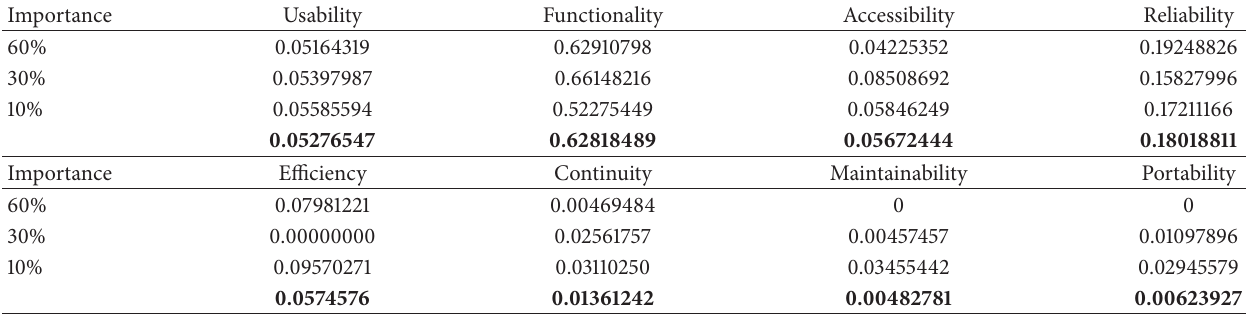
Table 3: Normalized value of the results obtained in Search Types 1, 2, and 3, respectively, for Quality Characteristics.